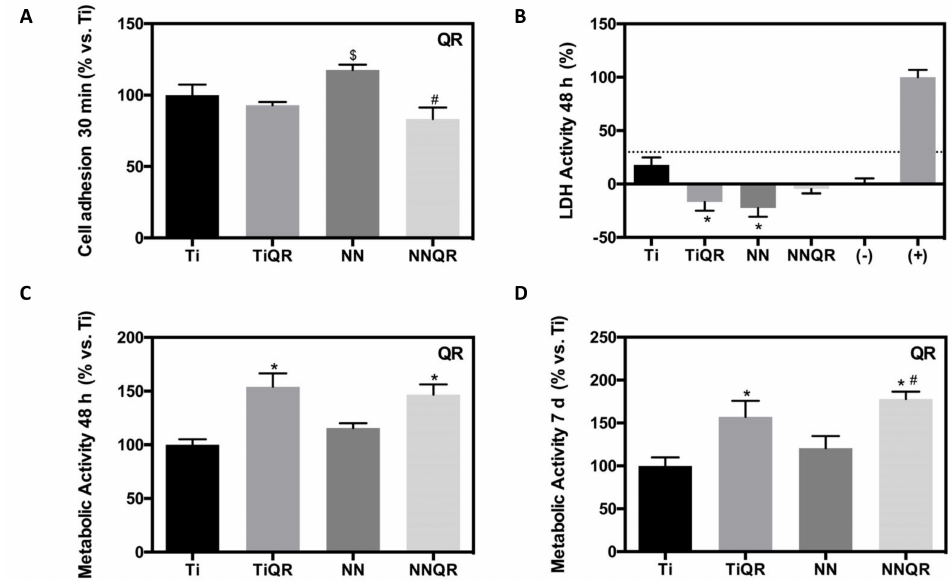
Figure 3. Surface bioactivity on human umbilical vein endothelial cells (HUVECs). ( A ) Cell adhesion to the surfaces after 30 min of incubation, expressed as % vs. Ti ( n = 6). ( B ) Cytotoxicity of cells cultured on the di ff erent surfaces, measured as LDH activity; cells cultured on (TCP) are considered ( − ) an cells treated with Triton 100X 1% are considered ( + ; n = 7). ( C ) Metabolic activity of cells cultured on the di ff erent surfaces for 48 h; results are expressed as % vs. Ti ( n = 7). ( D ) Metabolic activity of cells cultured on the di ff erent surfaces for 7 days ( n = 7). Values represent the mean ± S.E.M. Results were statistically compared by an ANOVA and Bonferroni as a post hoc for LDH activity and metabolic activity 7 d, by ANOVA and Games Howell as a post hoc for cell adhesion and by Kruskal–Wallis for metabolic activity 48 h. * p < 0.05 versus Ti; # p < 0.05 versus NN and $ p < 0.05 versus TiQR. QR indicates the e ff ect of quercitrin functionalization ( p < 0.05), as assessed by Student’s t -test for cell adhesion, LDH activity and metabolic activity 7 d and by Mann–Whitney for metabolic activity 48 h.